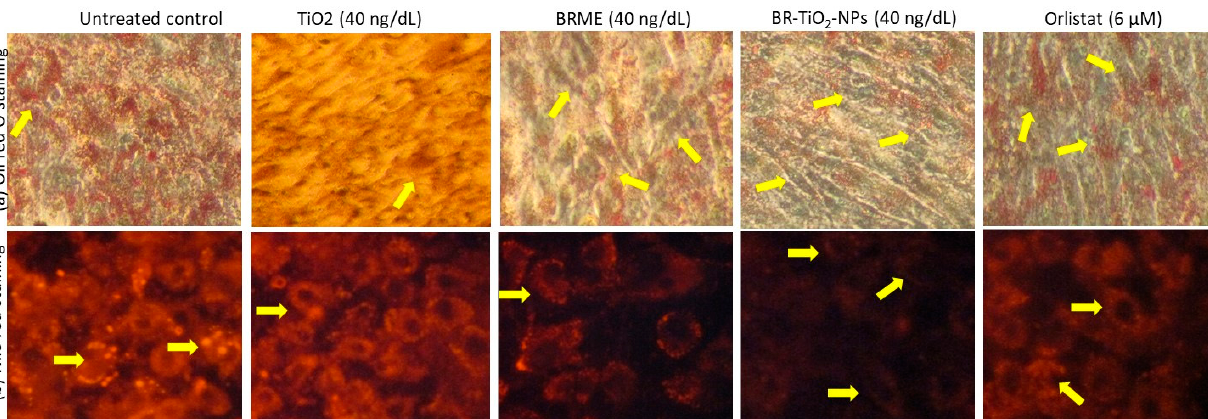
Figure 5. Effective dose determination for BR-TiO 2 -NPs by the lipid accumulation inhibition potential assay on adipocytes maturation after 14 days. Images of lipid accumulation by Nile red staining ( a ) and the lipid inhibition percentage as quantified after oil red’O staining ( b ). Each value is a mean ± SD ( n = 6). * Significant at p ≤ 0.05 and ** highly significant at p ≤ 0.001, by comparison with the untreated control.